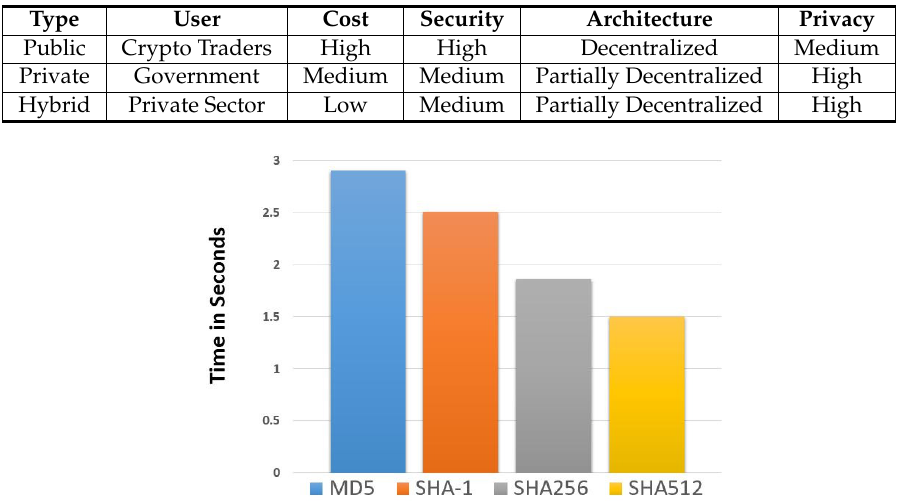
Table 2. Comparison among different blockchains [23].